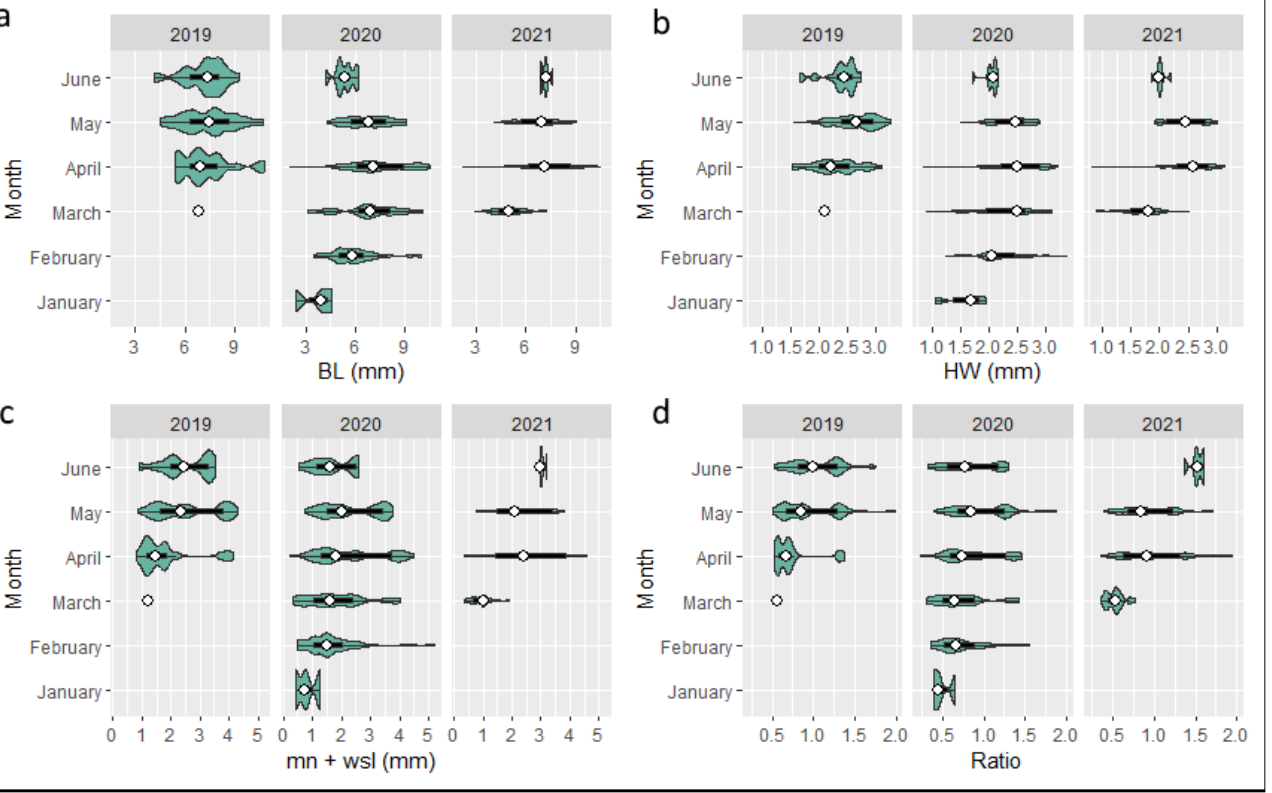
Figure 7. Seasonal changes in size–frequency distribution of Rhithrogena sartorii (2019–2021) for BL ( a ), HW ( b ), mn + wsl ( c ), and Ratio ( d ).